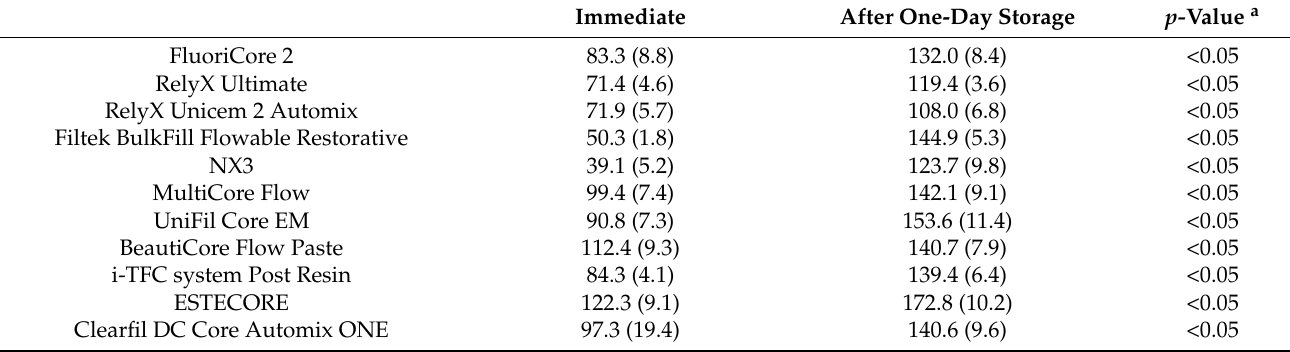
Table 8. Flexural strength of various Core build-up materials and luting materials (MPa, mean